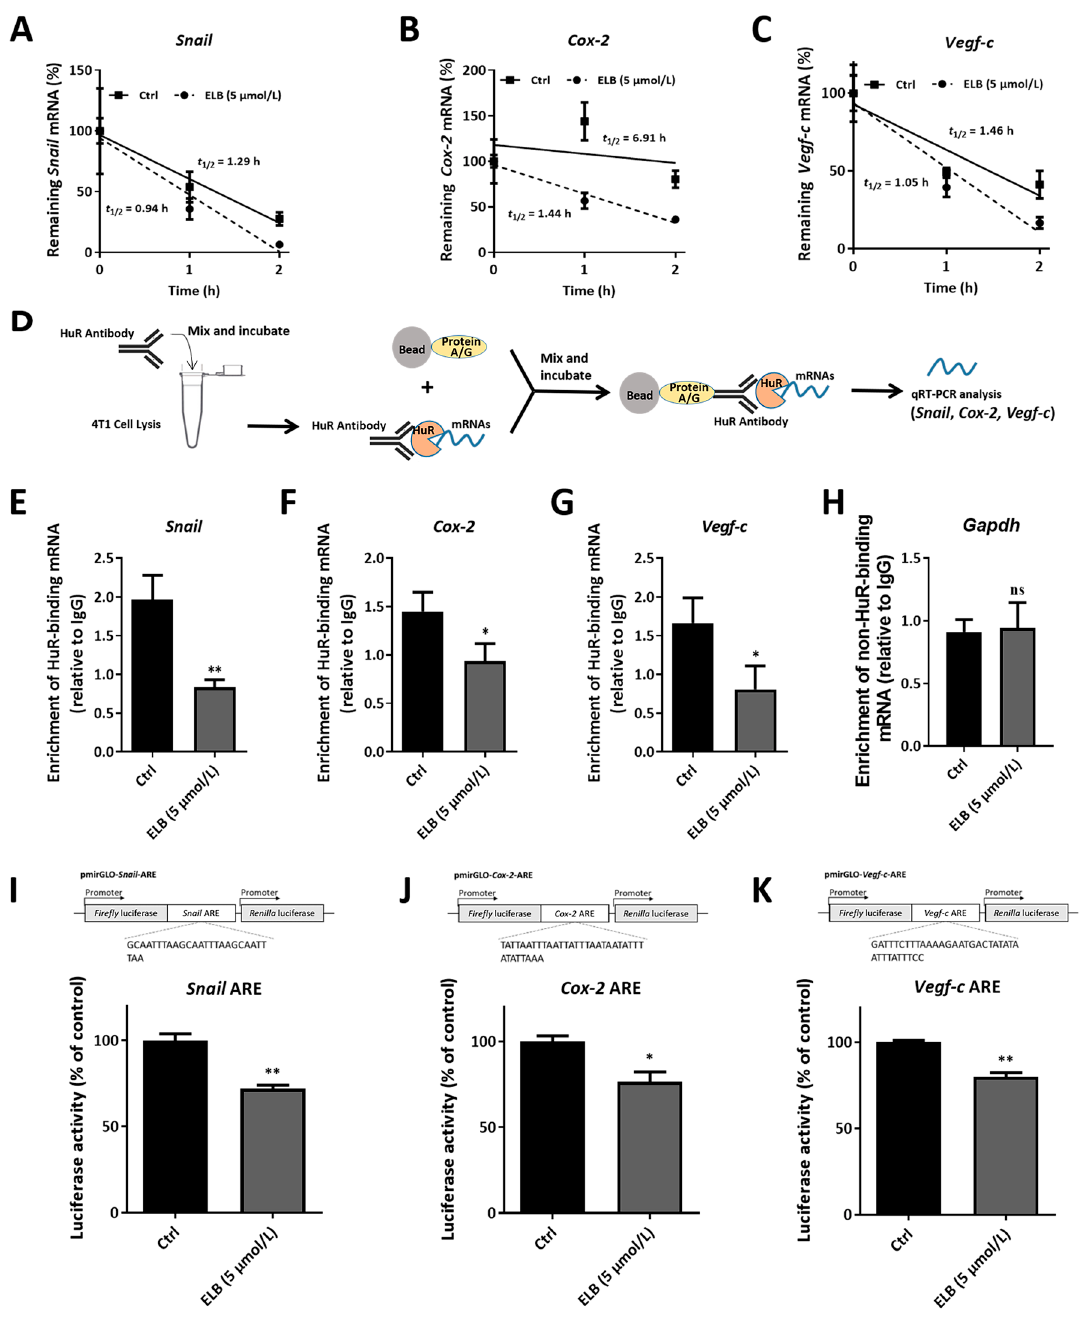
Figure 5. Eltrombopag regulated the function of the HuR protein in 4T1 cells. ( A – C ) The mRNA stability of Snail , Cox-2, and Vegf-c in 4T1 cells was impacted by eltrombopag. ( D ) Schematic diagram of the RIP analysis. ( E – H ) HuR-binding mRNA ( Snail , Cox-2, and Vegf-c ) and non-HuR-binding mRNA ( Gapdh ) levels in 4T1 cells influenced by eltrombopag detected with RIP. ( I – K ) Luciferase activity mediated by Snail -ARE, Cox-2 -ARE, and Vegf-c -ARE in 4T1 cells impacted by eltrombopag. Mean ± SD. n = 3. * p < 0.05 ( t -test), ** p < 0.01 ( t -test), ns means no significant difference.